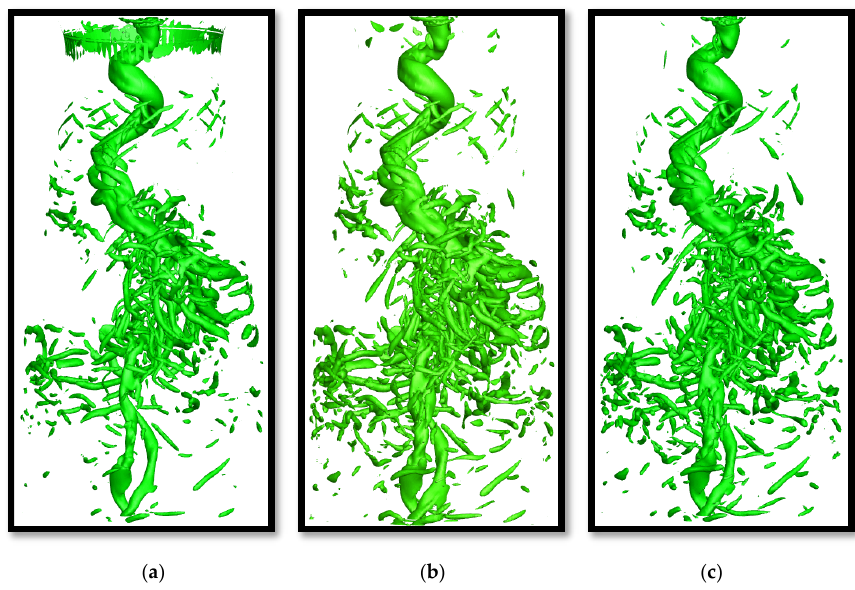
Figure 5. The morphology of vortex rope identified by three vortex identification methods at a cer- tain moment. ( a ) Q = 200,000 s −1 ; ( b ) Ω = 0.52; ( c ) l* = 500 s −1